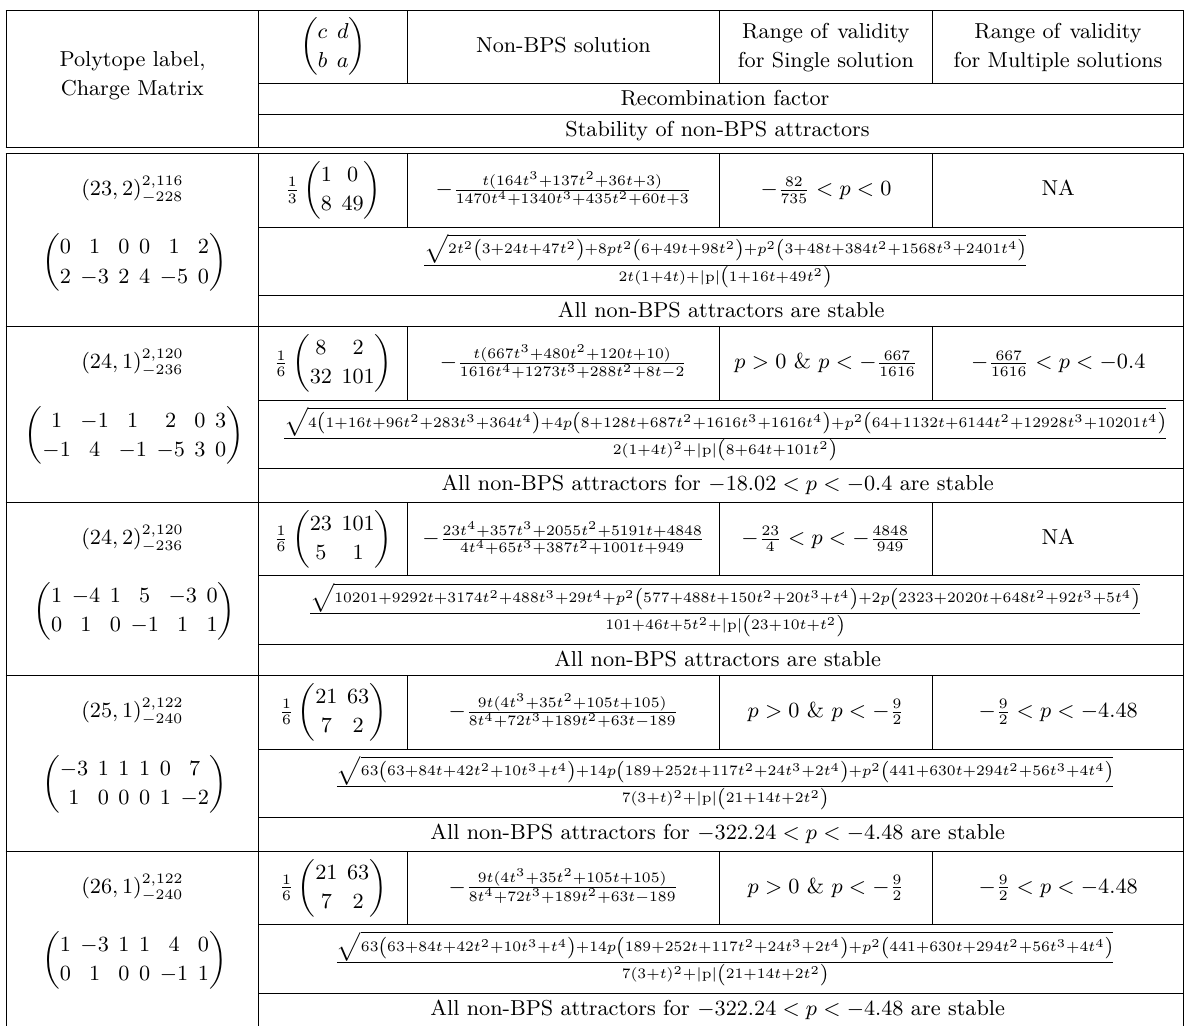
Table 16 . Non-BPS extremal (multiple) black strings in one-modulus THCY models,